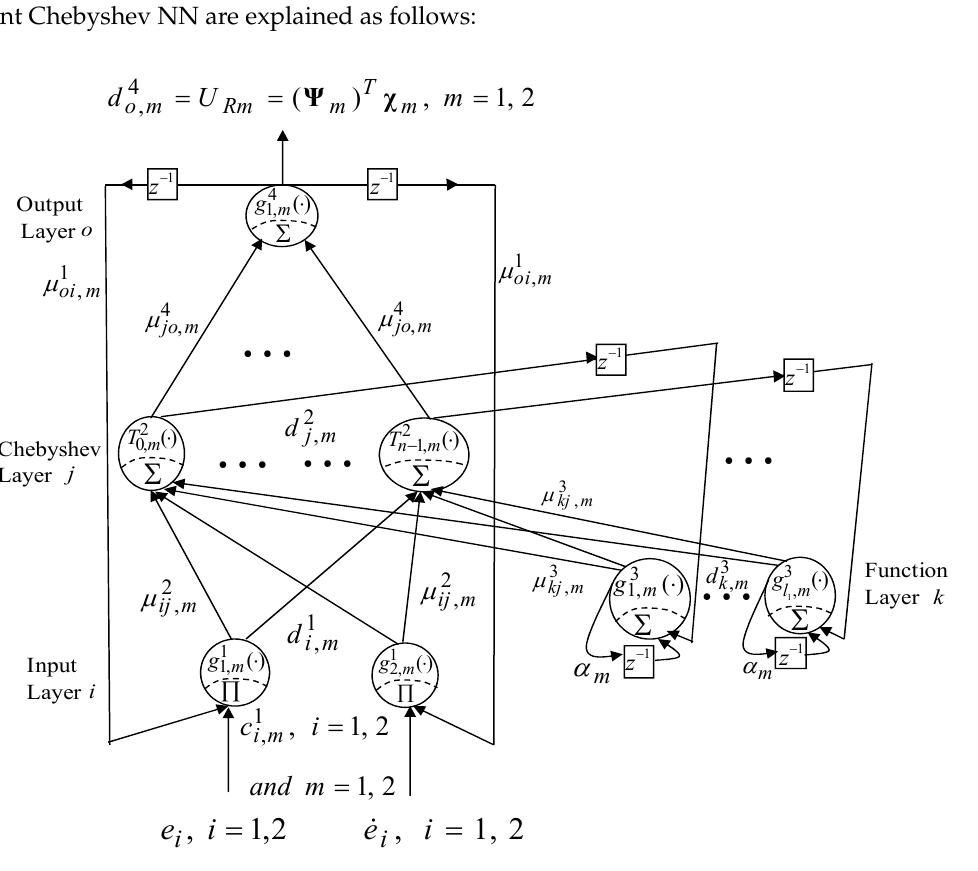
Figure 5. Architecture of the four ‐ layer novel recurrent Chebyshev NN.